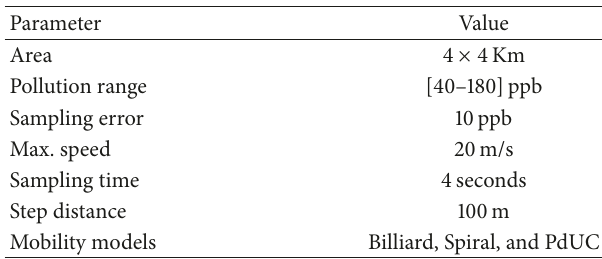
Table 1: Simulation